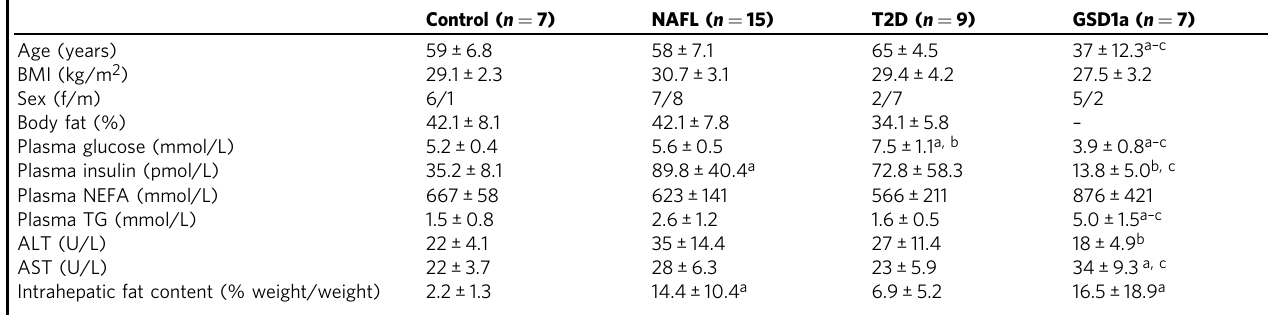
Table 1 Subject characteristics of control and NAFL participants, patients with T2D and GSD1a.